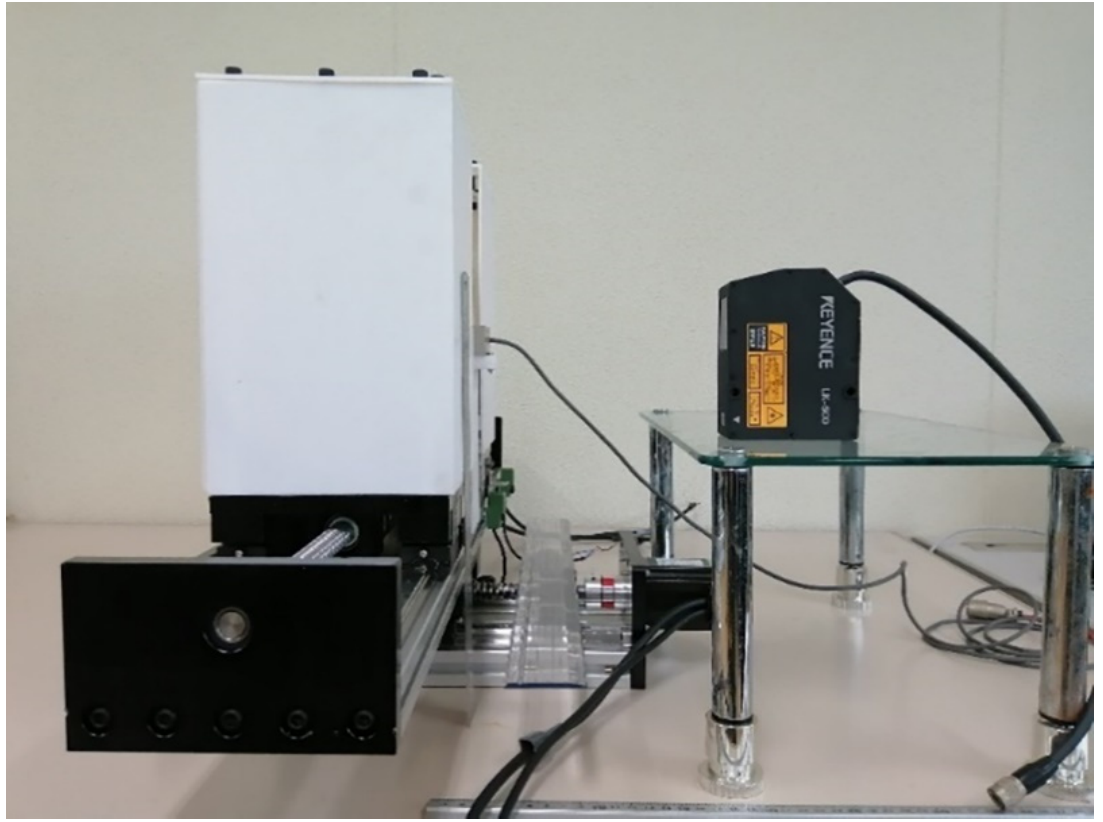
Figure 13. Line tracking test setup on the slave side.